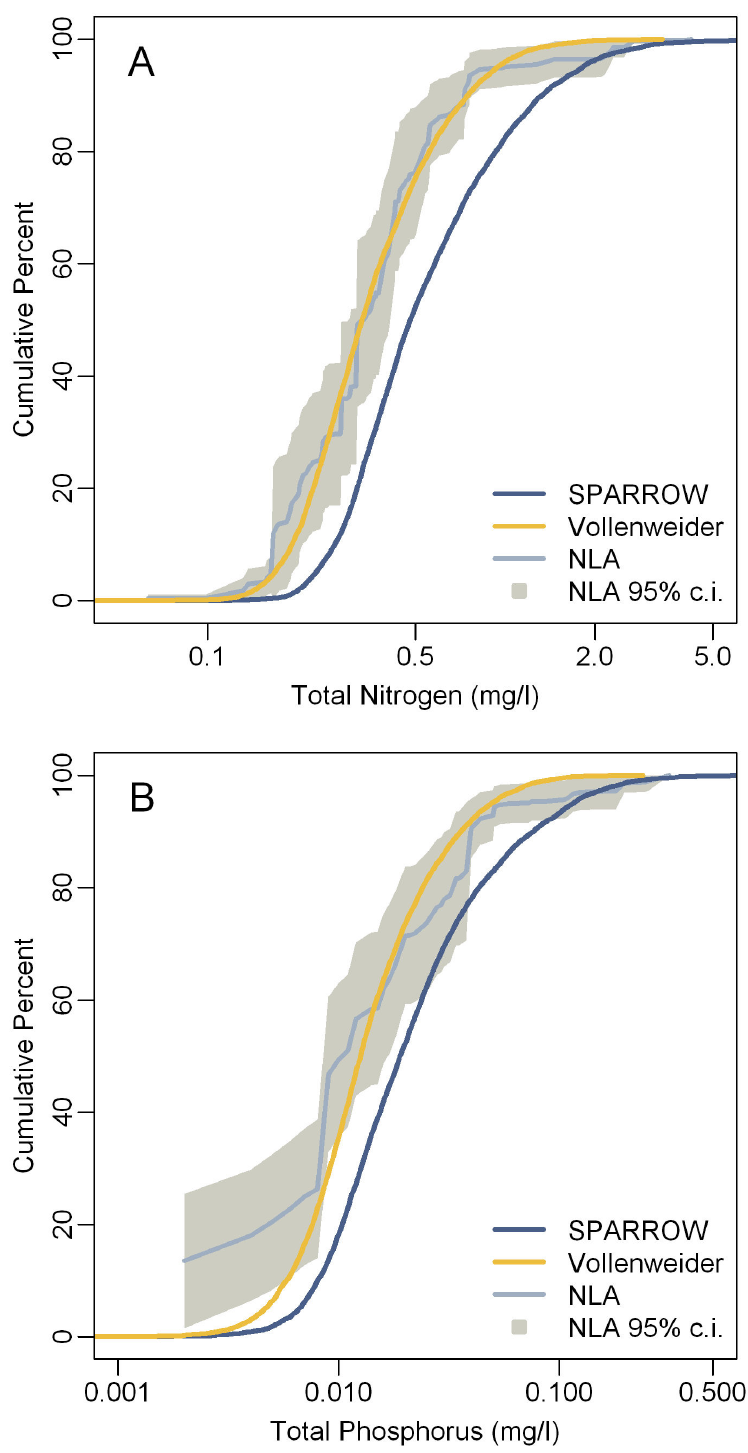
Figure 5. Cumulative distribution functions for observed and predicted nitrogen (A) and phosphorus (B) concentrations. Cumulative distribution functions for SPARROW predictions, the Vollenweider (H predictions, and the 2007 National Lake Assessment observations. The grey polygons represent the weighted 95% confidence intervals for the NLA cumulative distributions. Note: Only the SPARROW predictions consistent with the NLA sampling design (area ≥ 4 ha; maximum depth ≥ 1 m; n=7669) and the NLA lakes selected under the probabilistic design were included (n=98). doi: 10.1371/journal.pone.0081457.g005 PLOS ONE |